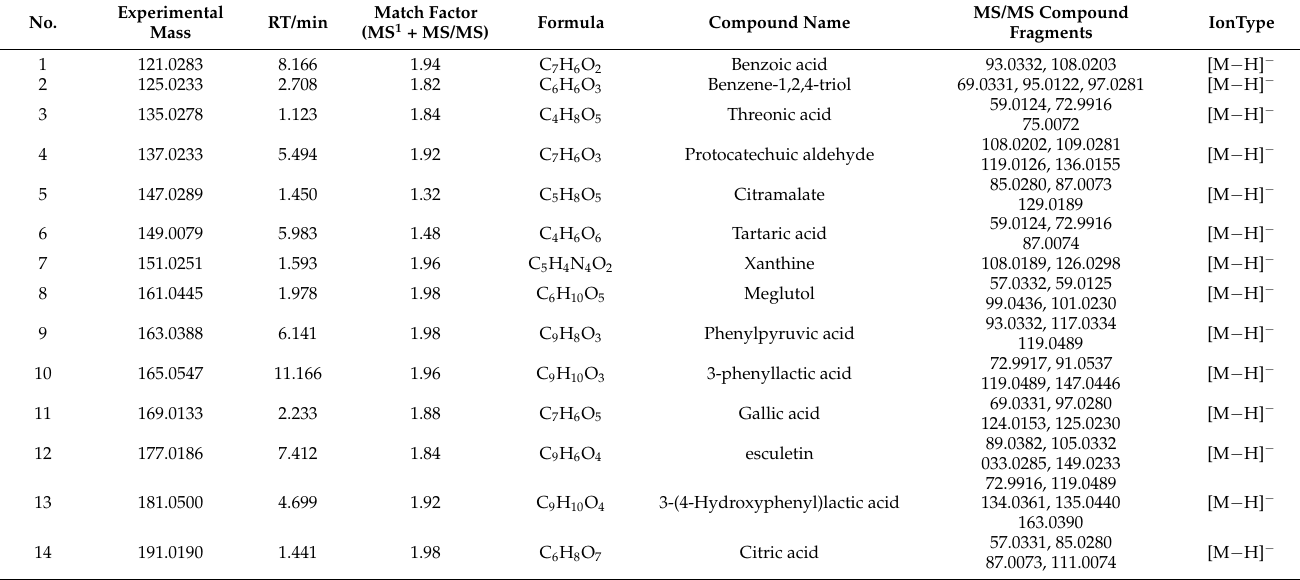
Table 2. The results of the compounds identified with MS 1 and MS/MS constructed with AntDAS in the negative ion